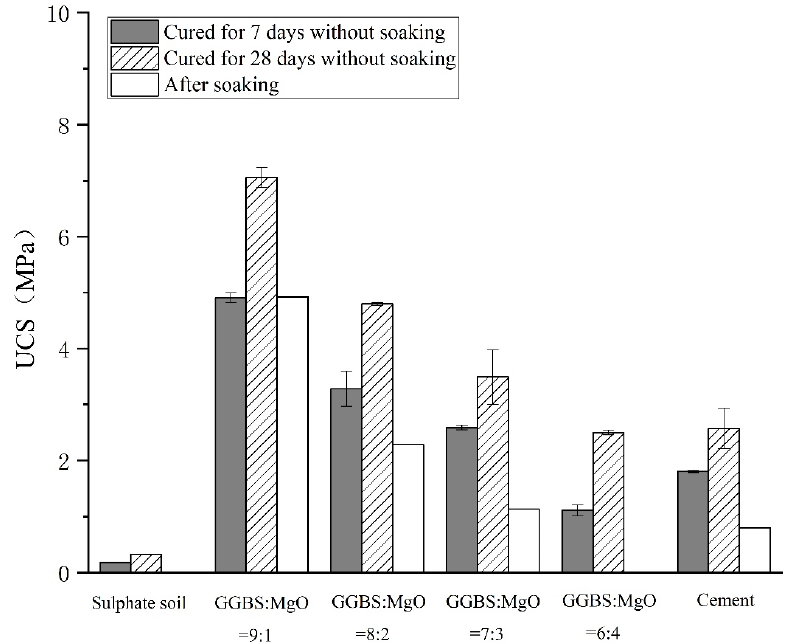
Figure 6. UCS of treated Ca-sulfate-soil at different curing and soaking stages. The strength of the untreated Ca-sulfate-soil was only 0.18 MPa; when the curing age increased, the strength increased to 0.33 MPa. This may be because the calcium ion in gypsum will consume some water with the increase in time, which will make the sample harder and thus improve the strength. Additionally, the strength was significantly im- proved after the addition of the curing agents. As for the specimen without soaking, the 7 and 28 days UCS reached the highest of 4.91 and 7.06 MPa, respectively, at GGBS:MgO = 9:1, and then reduced with the decrease in the GGBS-MgO ratio. This was in line with the result mentioned by [33] that over a high MgO content had a negative impact on the strength performance of soils with GGBS-MgO. Both GGBS-MgO and cement-treated soils showed a significant increase in UCS at 28 days curing compared to 7 days of curing. However, the soils treated with GGBS:MgO = 9:1, 8:2, and 7:3 always had a higher UCS than those treated with cement at different curing and soaking stages (7, 28 days curing, or after soaking). After soaking, the Ca-sulfate-soils with GGBS:MgO = 9:1, 8:2, and 7:3 all had higher UCS than the cement-treated soil (0.8 MPa). The highest UCS was achieved at GGBS:MgO = 9:1 which reached 4.92 MPa, while the GGBS:MgO = 6:4 treatment lost its load-bearing capacity, and thus was recorded as 0. Therefore, this result illustrated that the binder of GGBS-MgO, with proper GGBS:MgO ratios (e.g., 9:1 to 7:3), could more effectively im- prove the strength than cement for the Ca-sulfate-soil. Figure 7 provides the UCS of the treated Mg-sulfate-soils at different curing and soaking stages. Without soaking, both 7 and 28 days UCS decreased from the ratio of GGBS:MgO = 9:1 to 8:2 and then increased with the decreased ratio of GGBS-MgO. Such UCS (with a range of 0.24–0.85 MPa) were lower than those (0.85 and 1.21 MPa) of the cement-treated soils at the corresponding curing age. After soaking, the UCS of all of the treated Mg-sulfate-soils significantly decreased, to a range of 0–0.22 MPa, and cement- treated soil still had the highest UCS among all of the treated soils. This illustrated that for Mg-sulfate-soil, GGBS-MgO was less effective than cement in improving the strength.